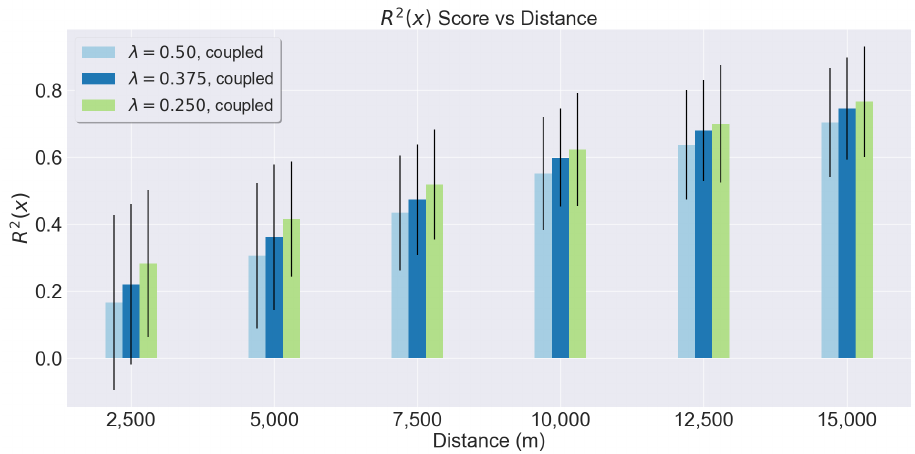
Figure 6. R2 score for different λ values. For each value, the average R2S score is shown, divided in two bars, one for the coupled evaluation and the second for the decoupled.